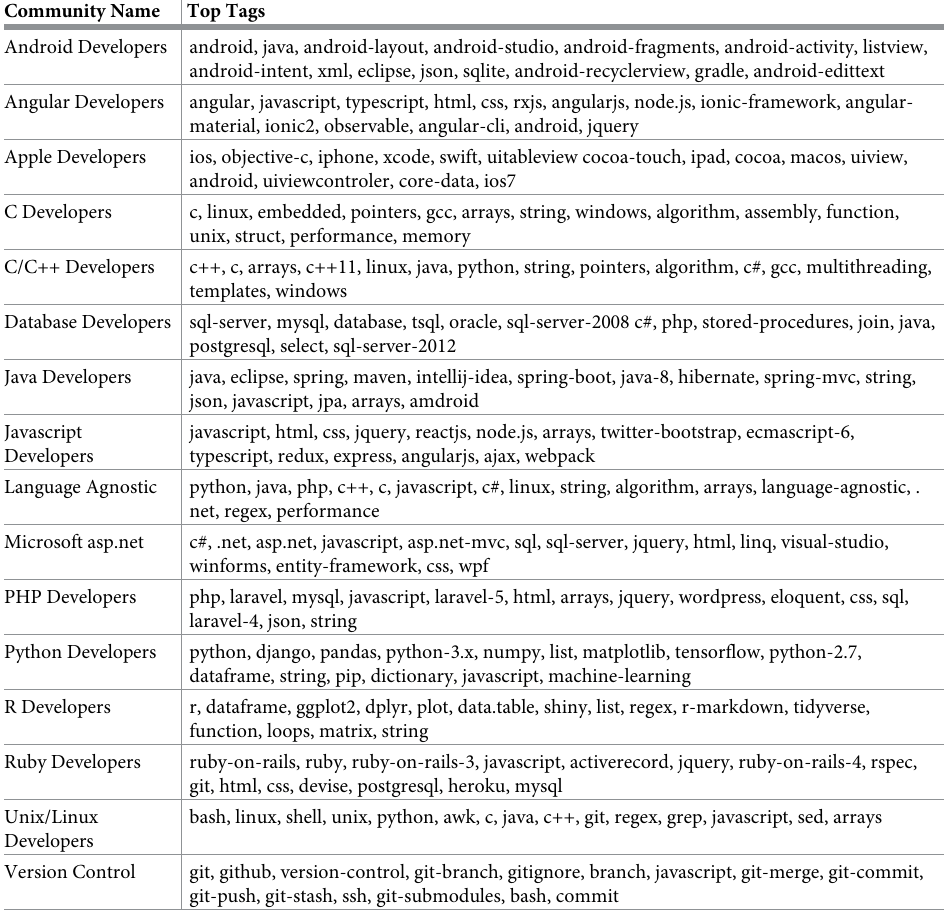
Table 3. Community